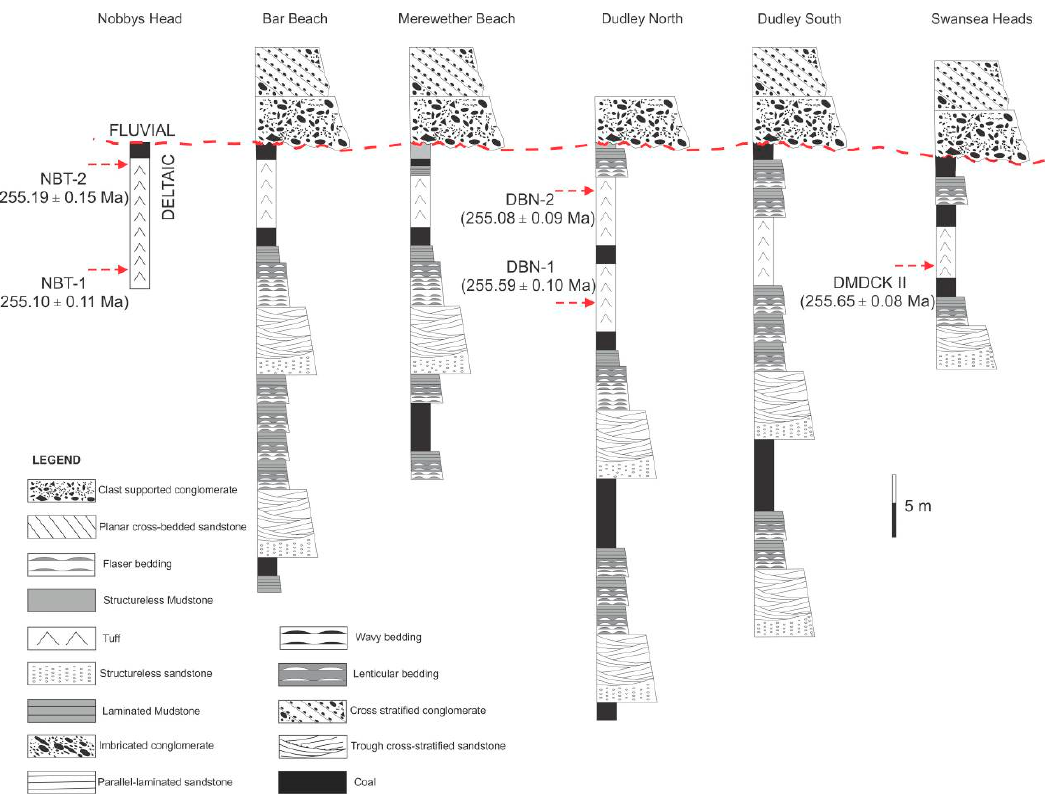
Figure 9. Synthetic stratigraphic cross section of the studied region that presents the spatial and temporal evolution of different depositional environments [18]. The construction of the cross section is based on stratigraphic and geochronological (CA-IDTIMS) evidence. Note the shoaling-upward trend as documented by the transition of tidally influenced delta-plain sediments to fluvial deposits. Red lines indicate interpreted boundaries between depositional settings.